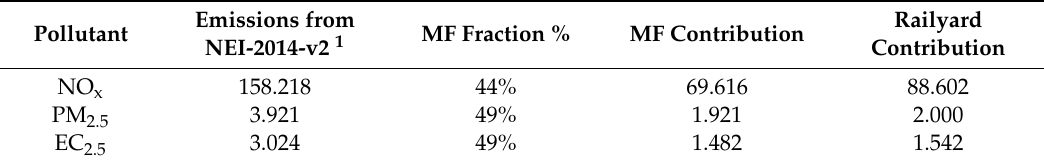
Table 1. Emissions (tons / year) for the Argentine rail yard and maintenance facility.